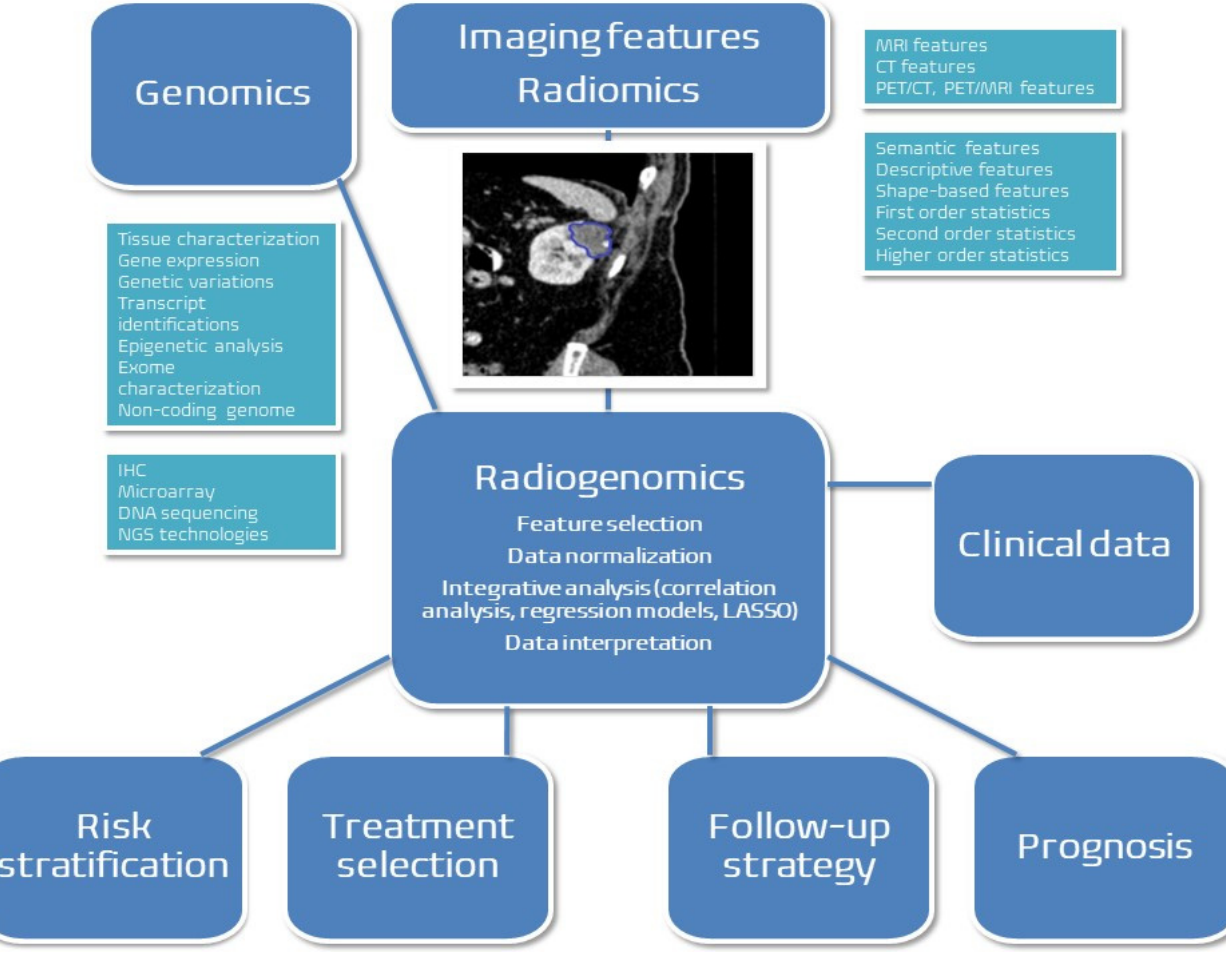
Figure 1. Radiogenomics combining radiomics from imaging features, genomics and clinical data with the purpose of improving clinical decision and patient selection for clinical studies (MRI = magnetic resonance imaging; CT = computed tomography; PET = positron emission tomography; IHC = immunohistochemistry; DNA = deoxyribonucleic acid; LASSO = least absolute shrinkage and selection operator; NGS = next-generation sequencing).